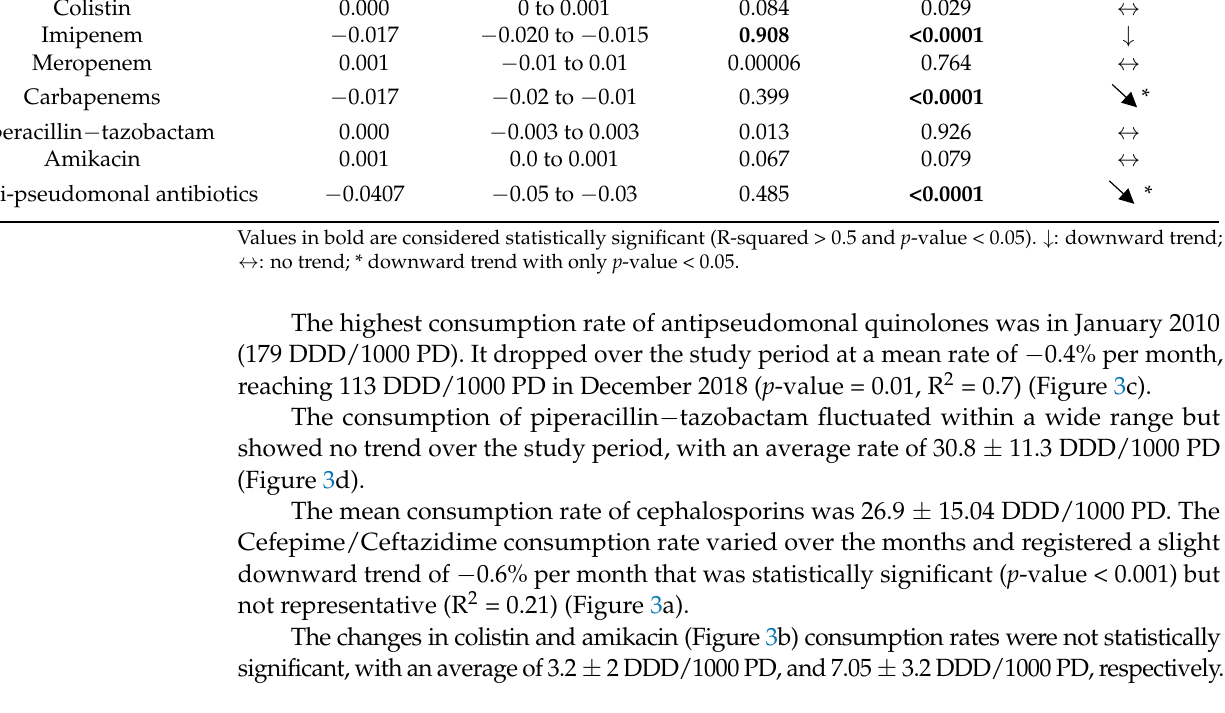
Table 3. Trends of antibiotic consumption between 2010 and